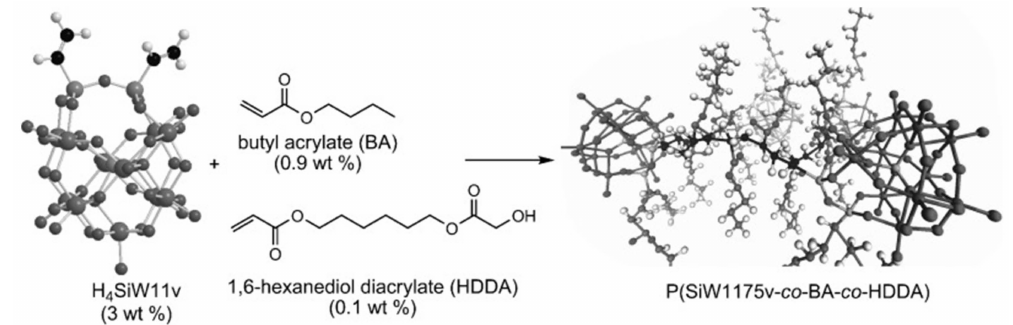
Figure 9. Synthesis of the copolymer (1,6-hexanediol diacrylate (HDDA) units in the copolymer are omitted for clarity). Reprinted with permission from [76]. Copyright (2009) John Wiley and